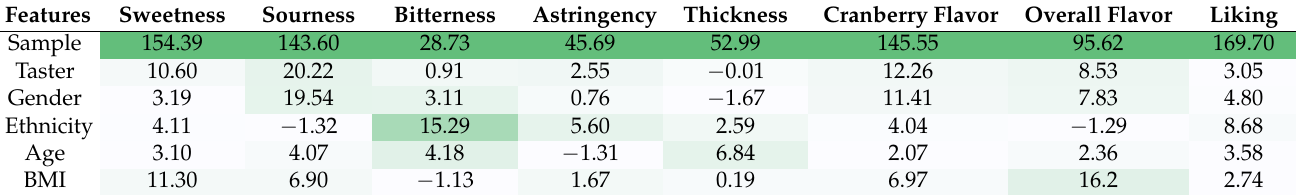
Table 4. Feature importance heatmap based on random forest modeling 1